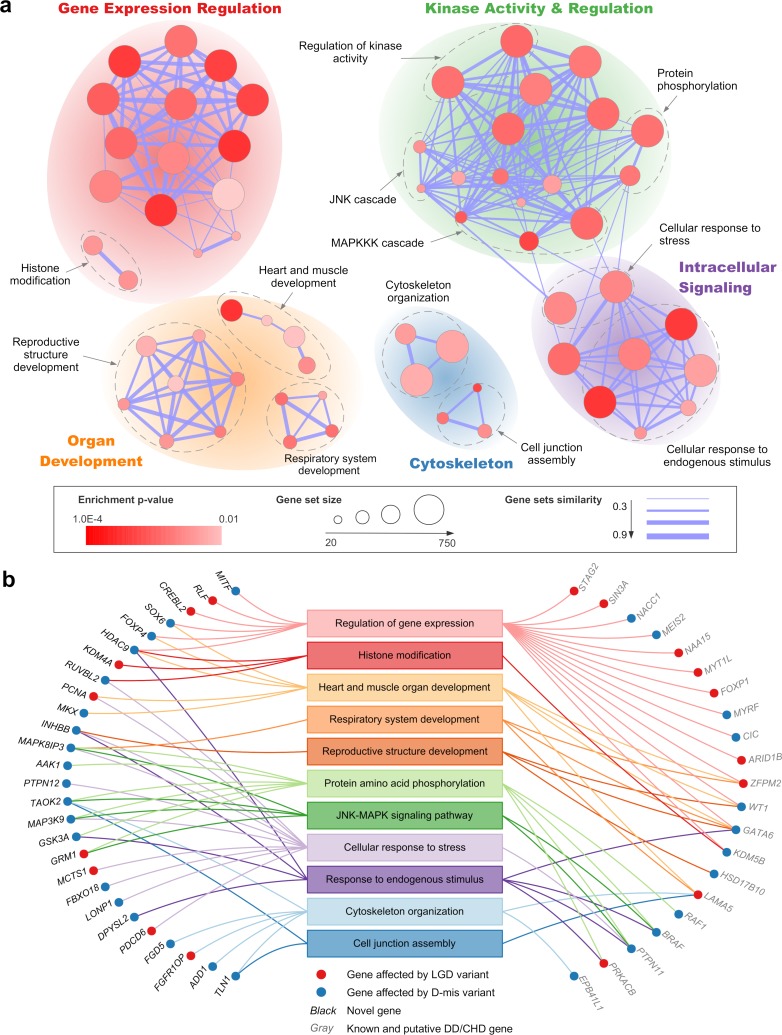
A functional enrichment map of genes affected by de novo damaging variants in CDH.(a) Enrichment results were visualized by a network of gene sets, where node size is proportional to the number of genes in each gene set and the thickness of edge represents the overlaps between gene sets. The significance of enrichment (p-value) is indicated by the color gradient. Functionally related gene sets are circled and manually labeled. Sub-clusters of network with similar functional annotations are grouped together as functional modules. (b) Mapping genes affected by damaging variants in CDH to the enriched functional groups shown in (a).